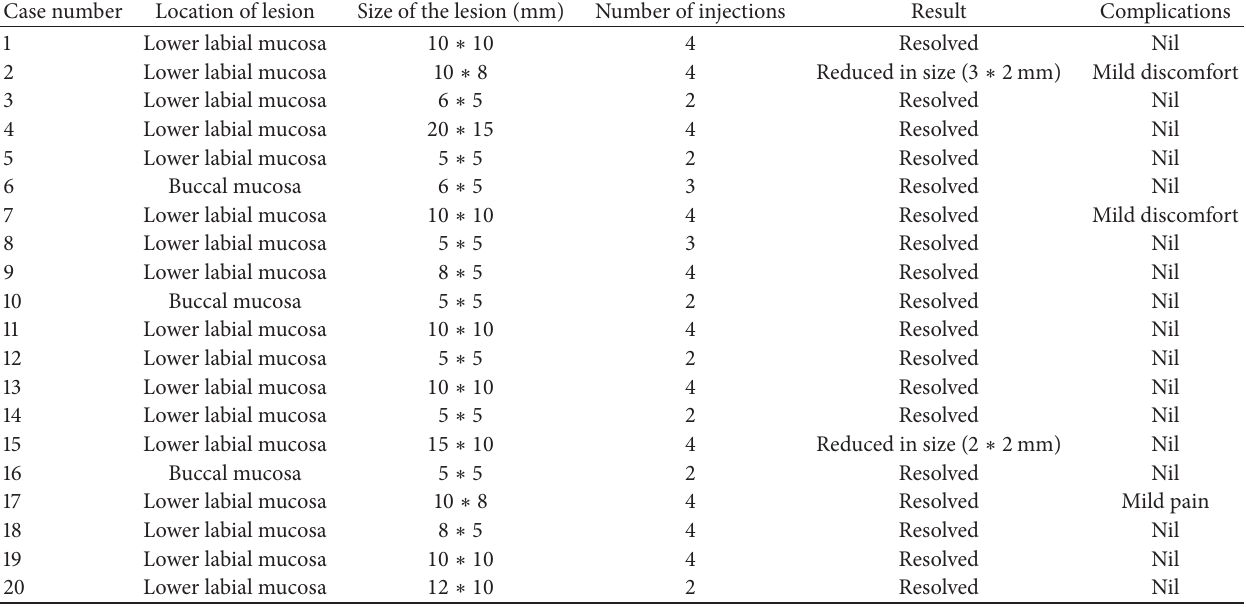
Table 1: Distribution of cases in intralesional corticosteroid therapy in oral